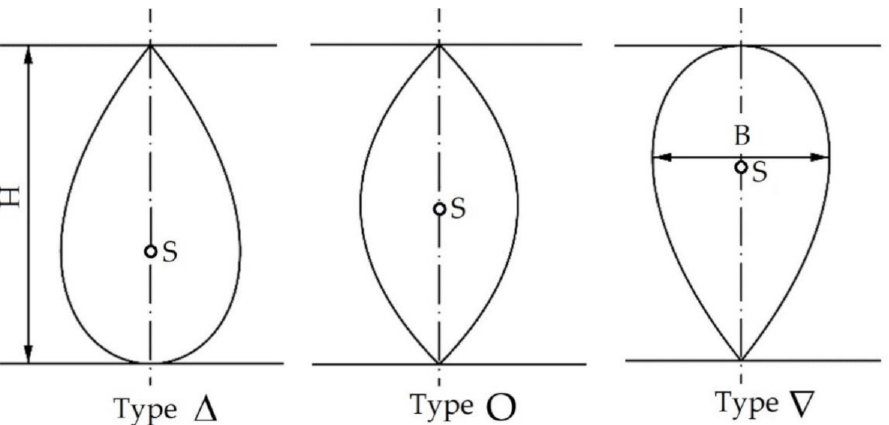
Figure 1. Bulbous bows according to the shape of the cross-section at the fore perpendicular, prepared on the basis of the information provided by Kracht’s [9], H—height, B—breadth, S—centre of gravity of bulbous bows sectional